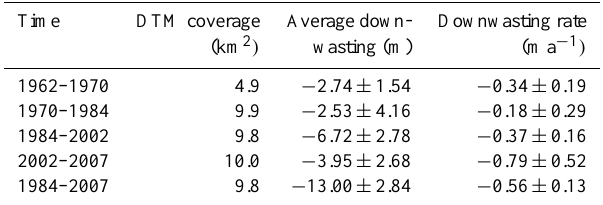
Table 4. Volume loss of the ablation area of Khumbu